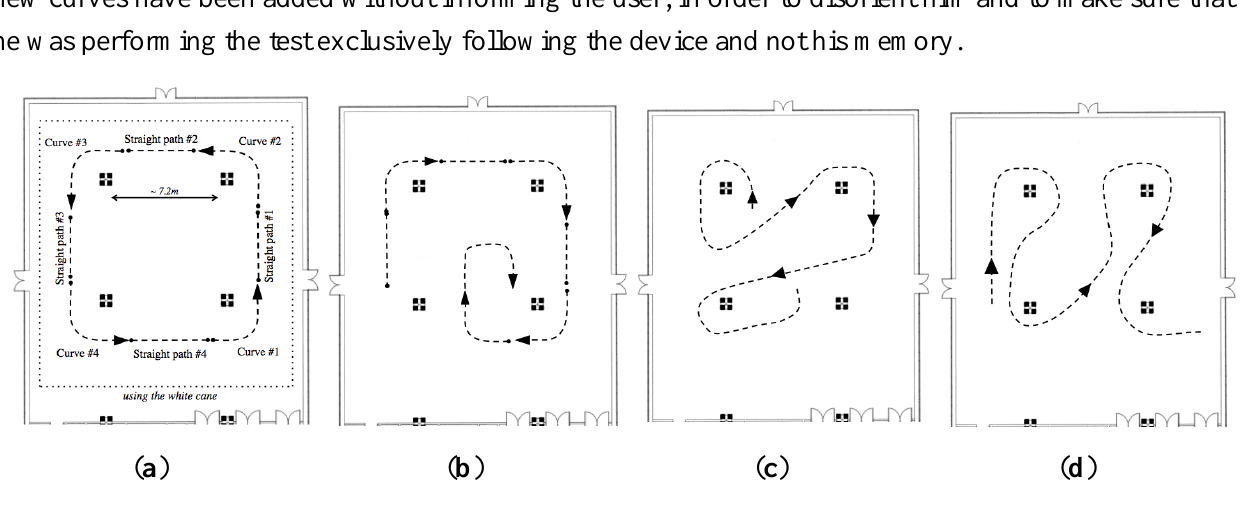
Figure 15. Schematic representations of different types of path performed in a big room ( b ) A turn along room perimeter and a final U-turn. ( c , d ) Complex paths with different curves and